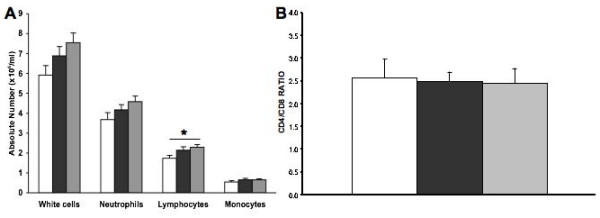
Blood inflammatory cells counts and CD4/CD8 ratio. A) Distribution of systemic inflammatory cells in the three groups obtained by automatized cell count. B) PBMC were isolated from each subjects, double labelled with fluorochrome-conjugated antibodies (CD3/CD4 and CD3/CD8), and analysed by flow cytometry. For each subject, CD4/CD8 ratio was obtained by dividing the %CD3+/CD4+ cells by the %CD3+/CD8+ cells. Columns represent mean ± SEM. *p = 0.02. Normal non-smokers (white), normal smokers (black), and emphysematous smokers (grey).